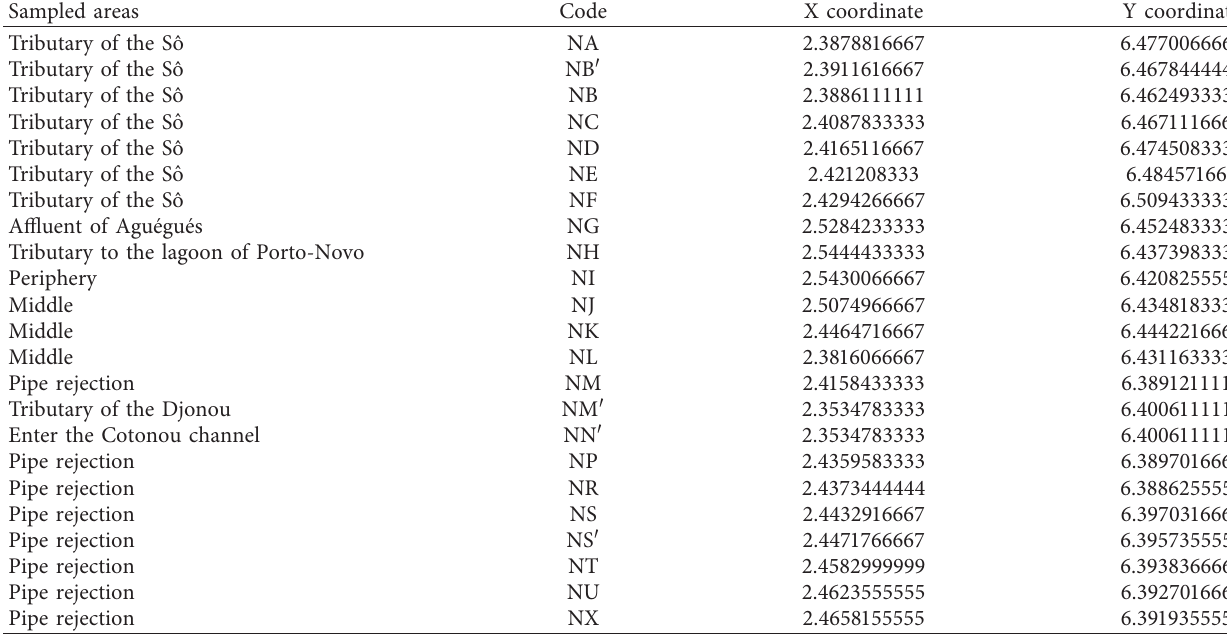
Table 1: Geographical coordinates of the sampled